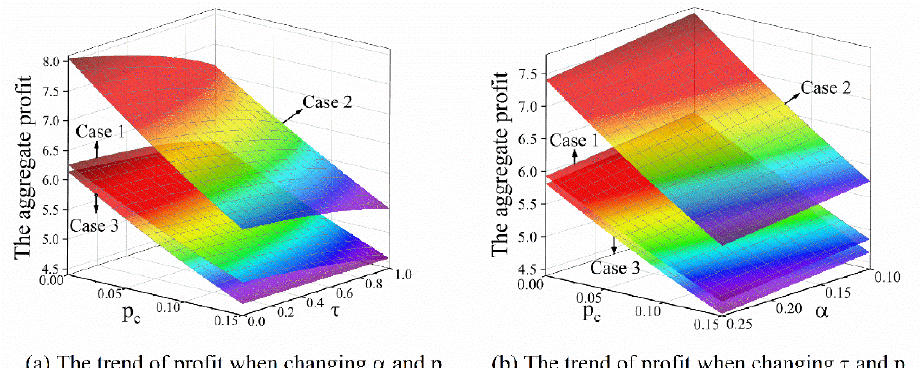
Figure 14. The aggregate profits of the supply chain under different levels of α , τ , and p c .